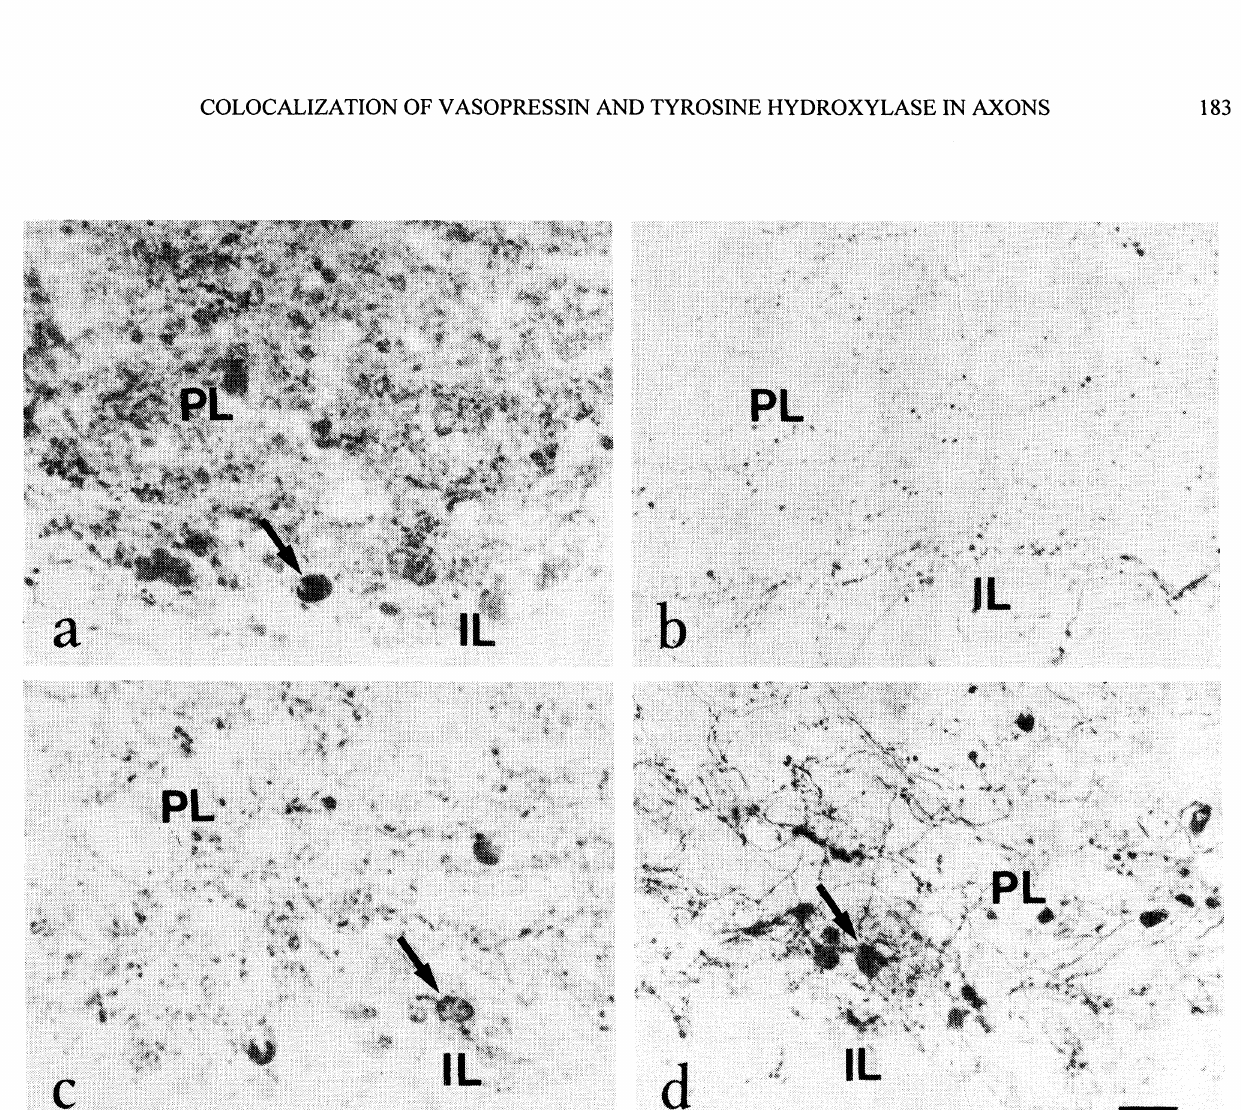
Fig. 1: Vasopressin-immunoreactive (a, c) and tyrosine hydroxylase-immunoreactive (b, d) Herring bodies (arrows) in the posterior lobe (PL) of intact rats (a, b) and following the osmotic stimulation for a week (c, d). Avidin-biotin technique. IL intermediate lobe. Scale bar 20 tm for a, c, d; 25 lxm for